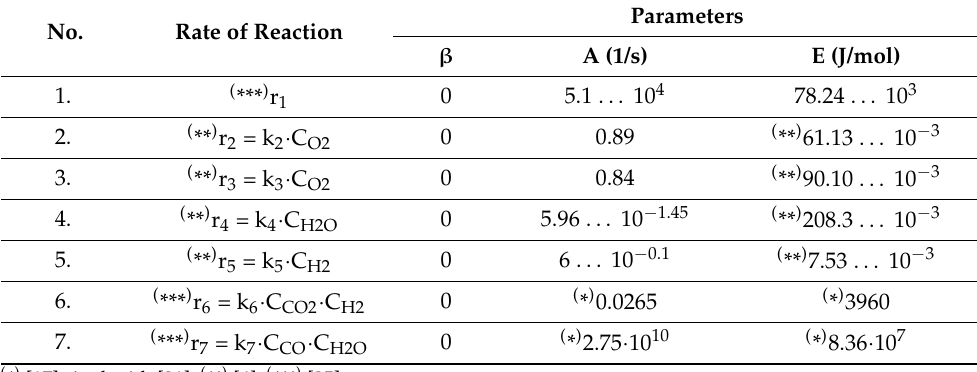
Table 5. The parameters adopted in the calculation of the chemical reactions of coal gasification. No. Rate of Reaction